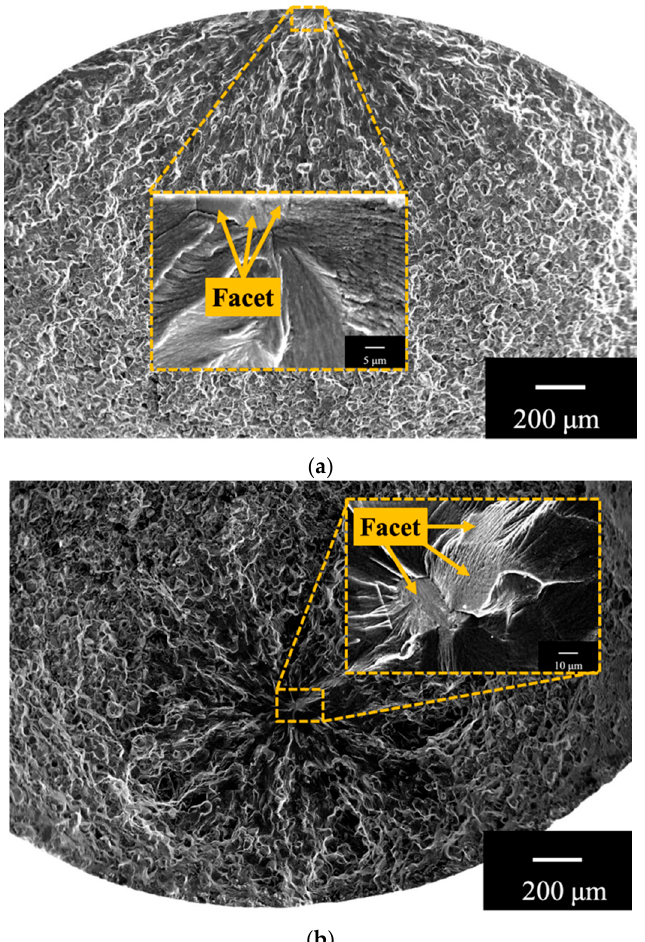
Figure 3. SEM images of the fracture surface. ( a ) Surface fracture, σ max = 700 MPa, R = − 1, N f = 3.5 × 10 4 ; ( b ) Internal fracture, σ max = 975 MPa, R = 0.1, N f = 4.5 × 10 6 .